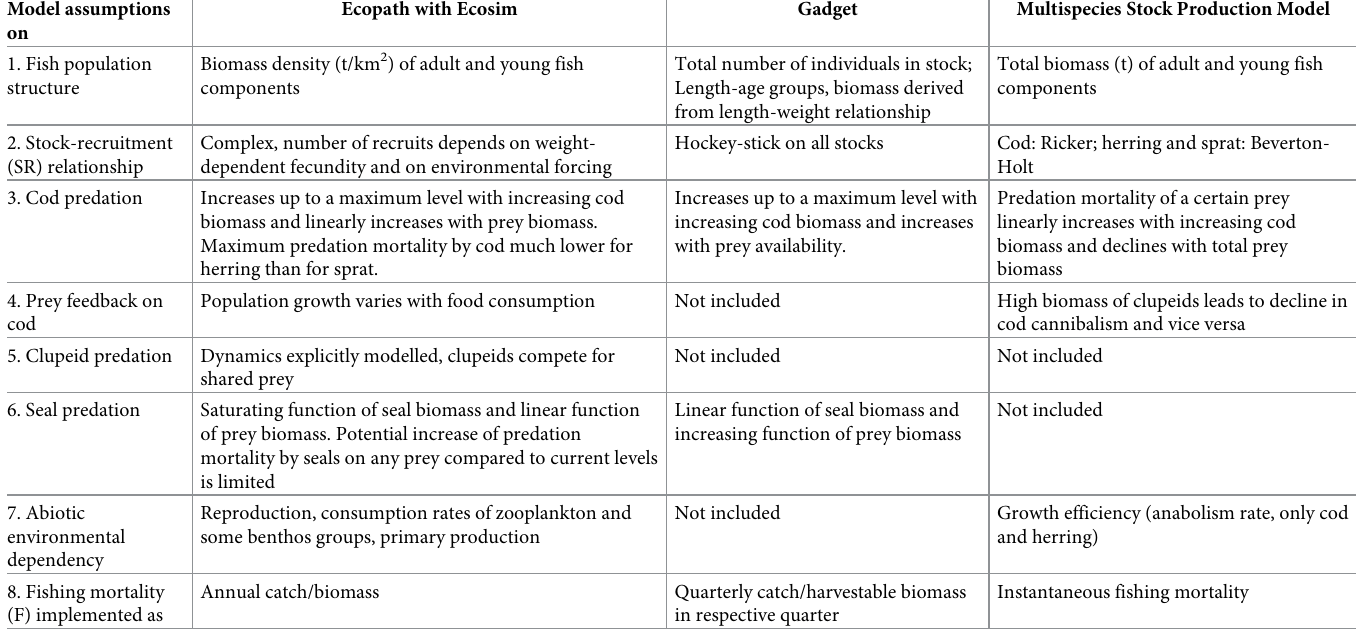
Table 1. Comparison of key assumptions with respect to population structure (1–3), trophic interactions (3–6) and human and abiotic environmental pressures (7– 8). Model assumptions Ecopath with Ecosim Gadget Multispecies Stock Production on